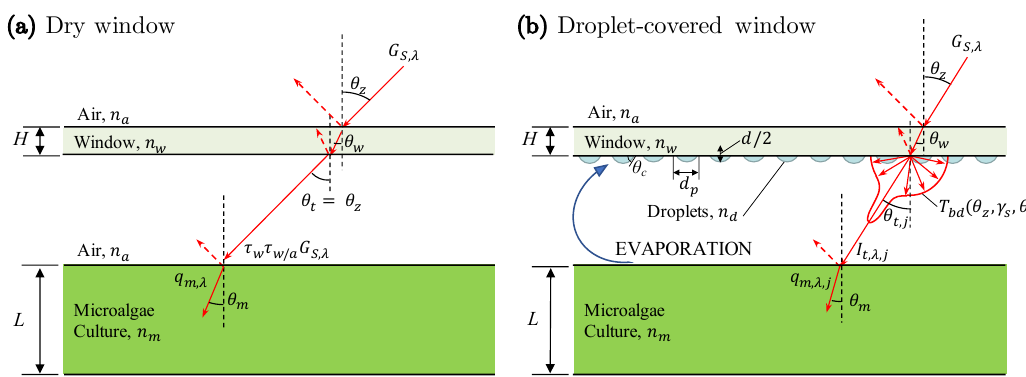
Figure 2. Side view (not to scale) of the covered outdoor PBRs studied with ( a ) a dry window and ( b ) a droplet-covered window. In both cases, a portion of the solar radiation was reflected at each interface before the radiative flux q m , λ , j was transmitted into the microalgae culture at angle θ m . Scattering by cap-shaped droplets on the window’s back side was described by the bidirectional transmittance T bd